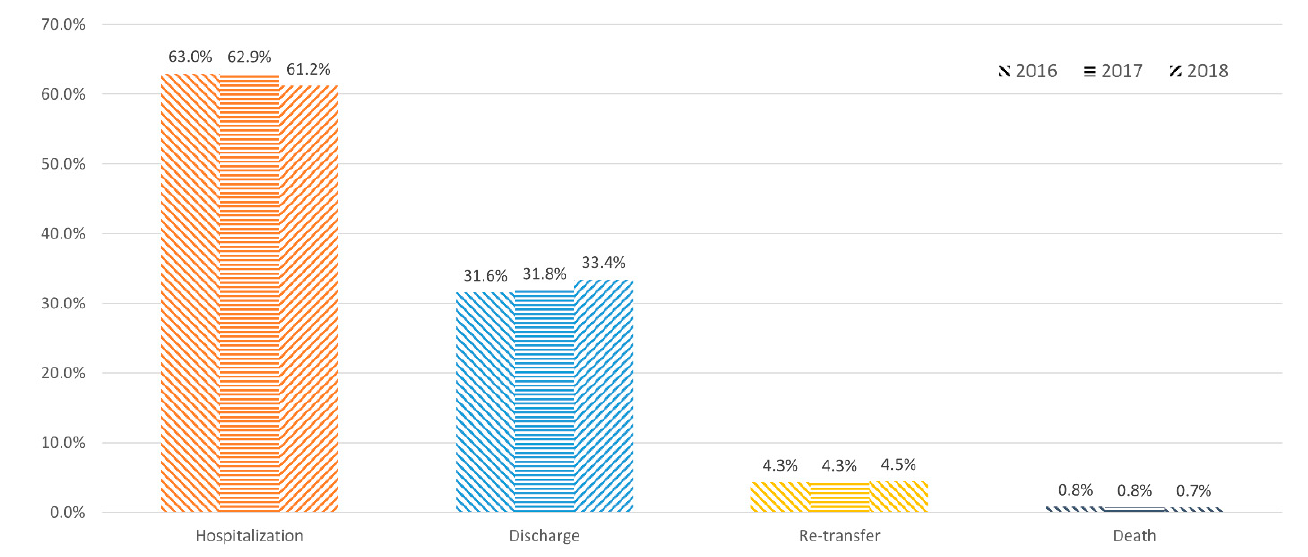
Figure 3. Trends in the disposition of patients who were referred. Each year is indicated with a different type of pattern. The hospitalization rate decreased from 63.0% to 61.2%, whereas the discharge rate increased from 31.6% to 33.4%. The re-transfer and death rates were almost stationary.